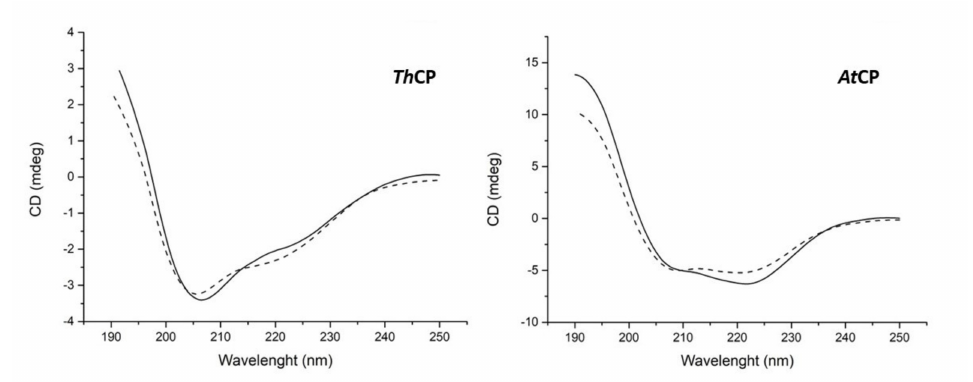
Figure 3. Circular dichroism (CD) spectra of CPs (0.05 mg / mL) from T. harzianum ( Th CP) and from A. terreus ( At CP) dissolved in 10 mM phosphate bu ff er pH 7. Dotted lines indicate CD spectra of the same samples acquired after 1 month of storage.